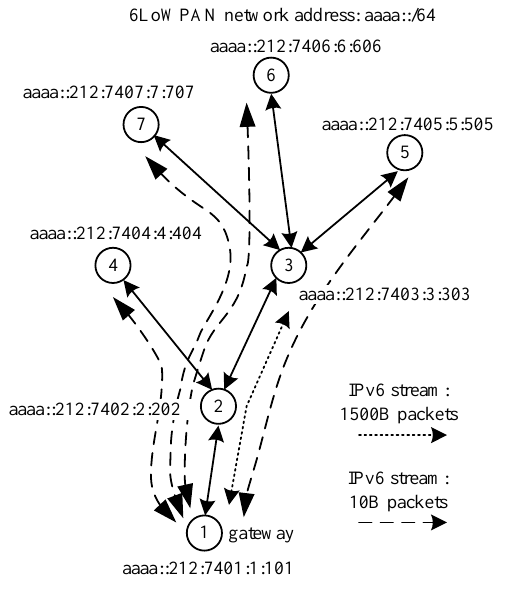
Figure 10. Multihop WSN.